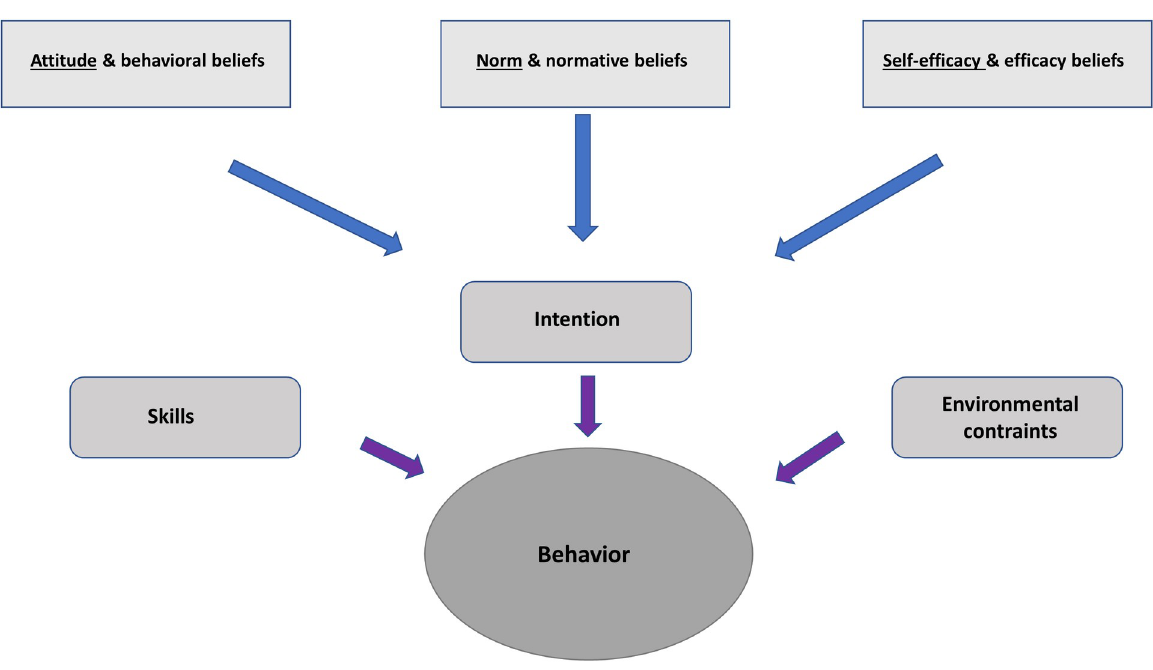
Fig 1. Fishbein’s integrative model of behavior prediction (adapted from